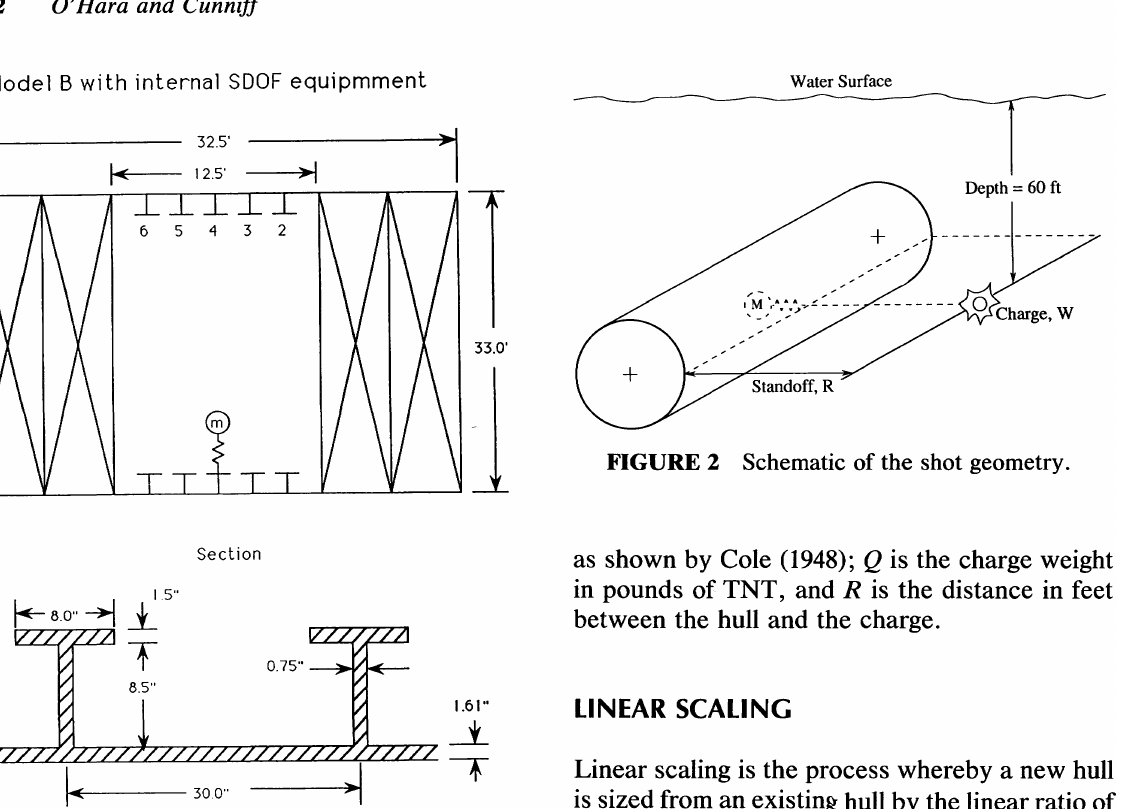
FIGURE 1 Details of model B.